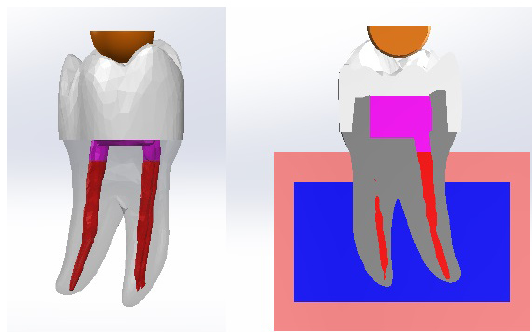
and converted into solid parts. Then, cortical bone and can-